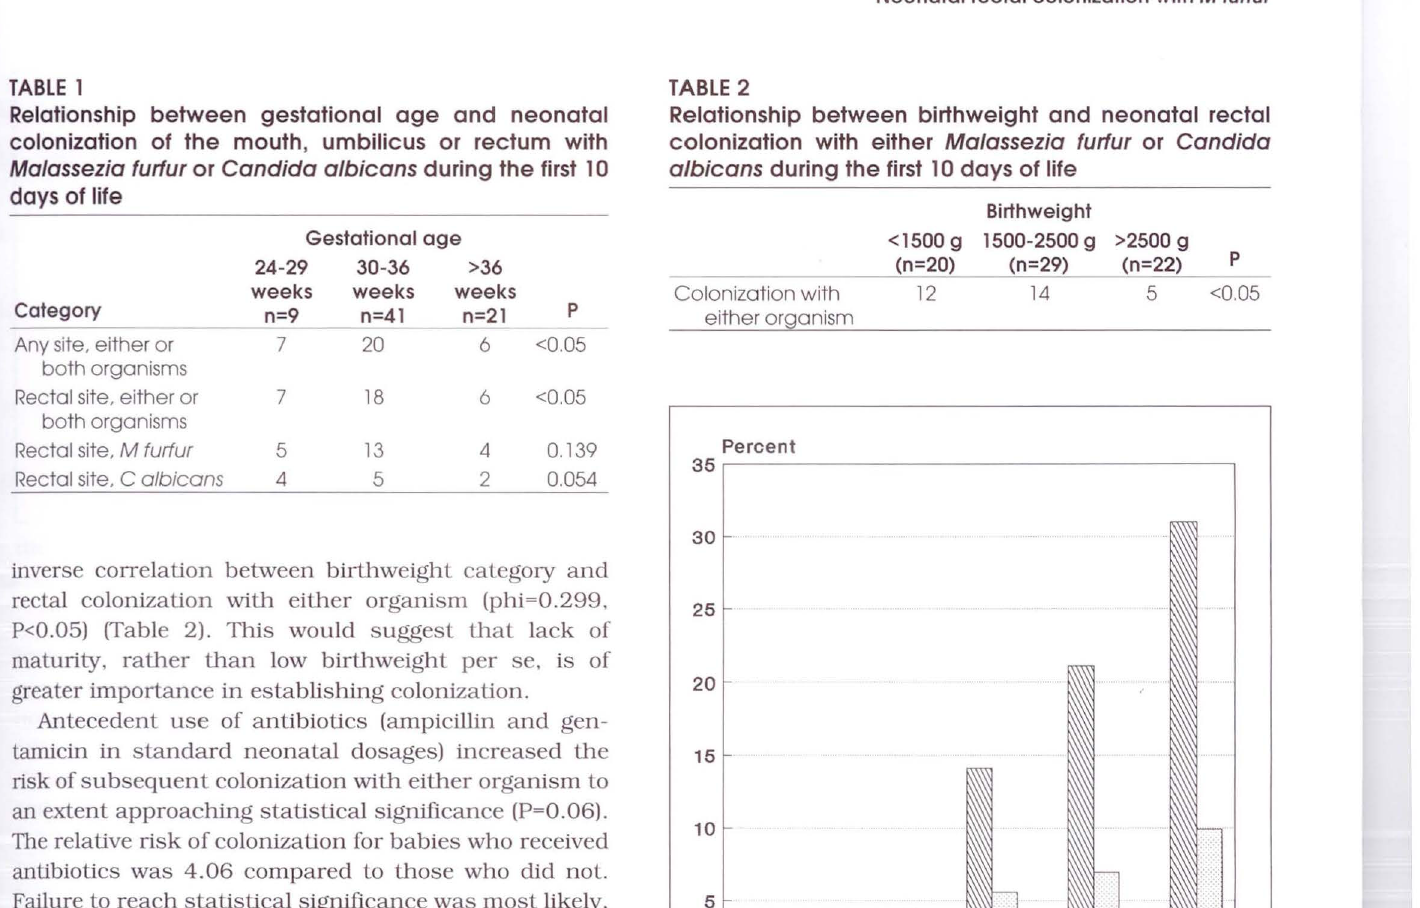
Figure 1) Cumulative colonization with Malassezia fur